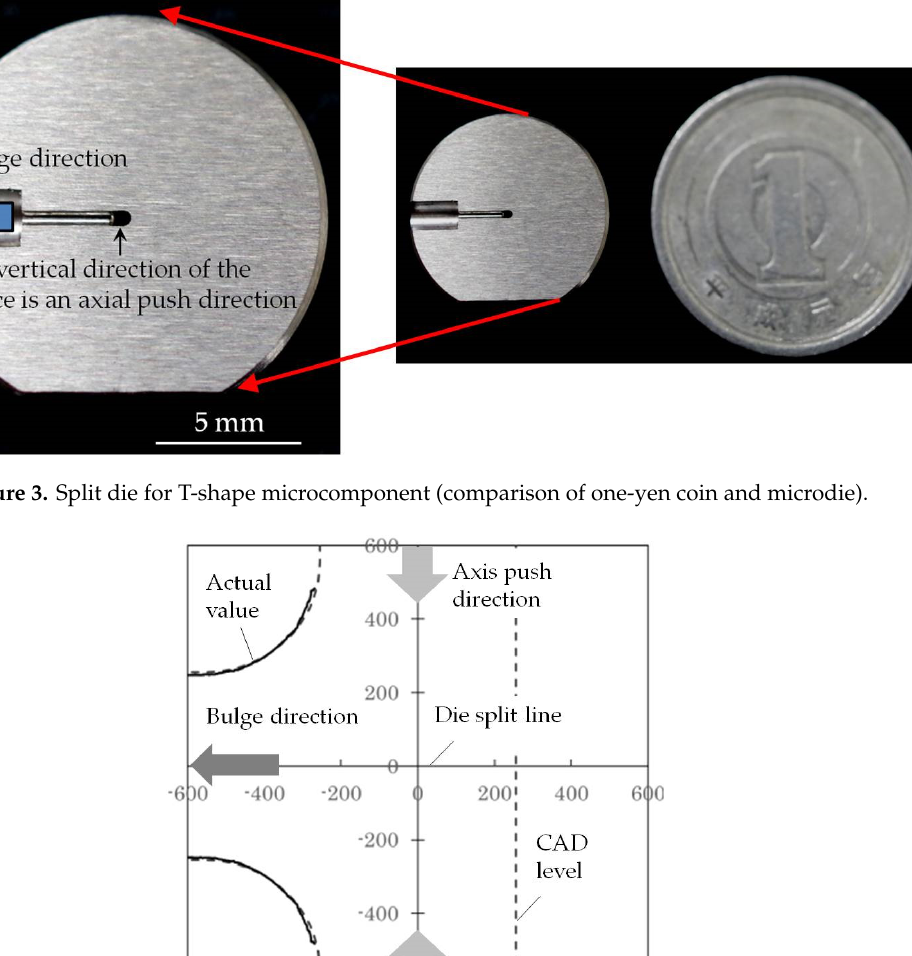
(THF) system (unit, mm): ( a ) die; ( b ) axial punch with groove.